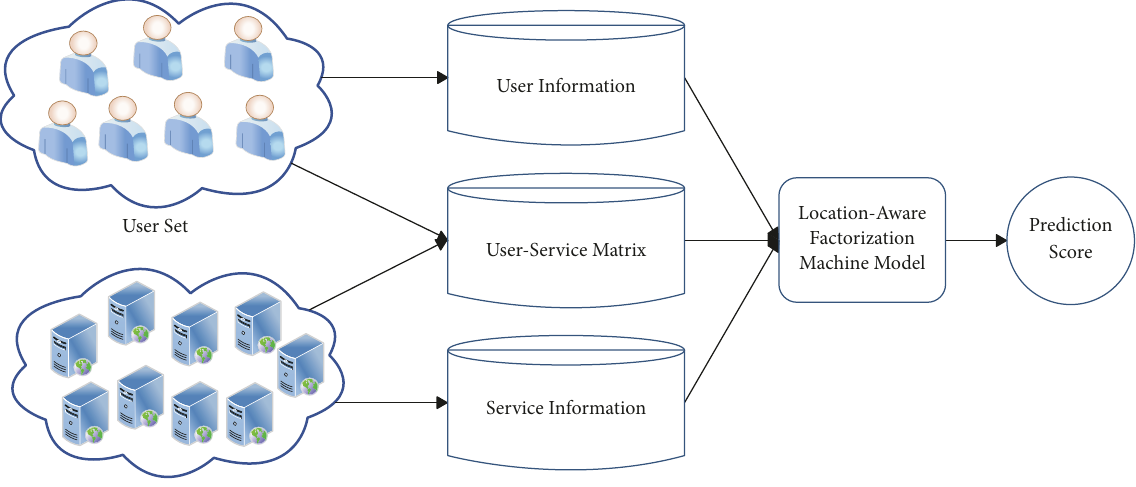
Figure 3: Framework of our LANFM